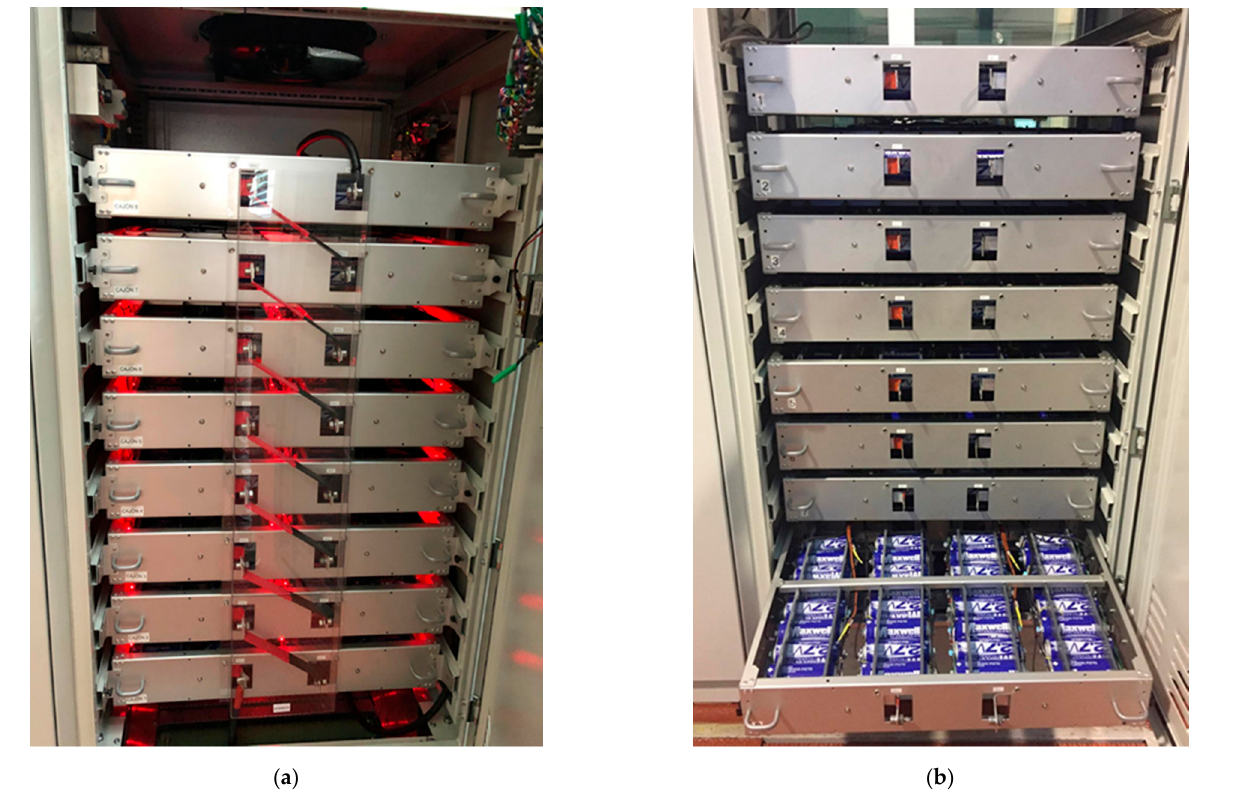
Figure 3. ( a ) Image of one supercapacitor energy storage system (SCESS) module during a voltage balancing process between cells and ( b ) image of one of the eight drawers that make up the SCs cabinet upon which this study is based.